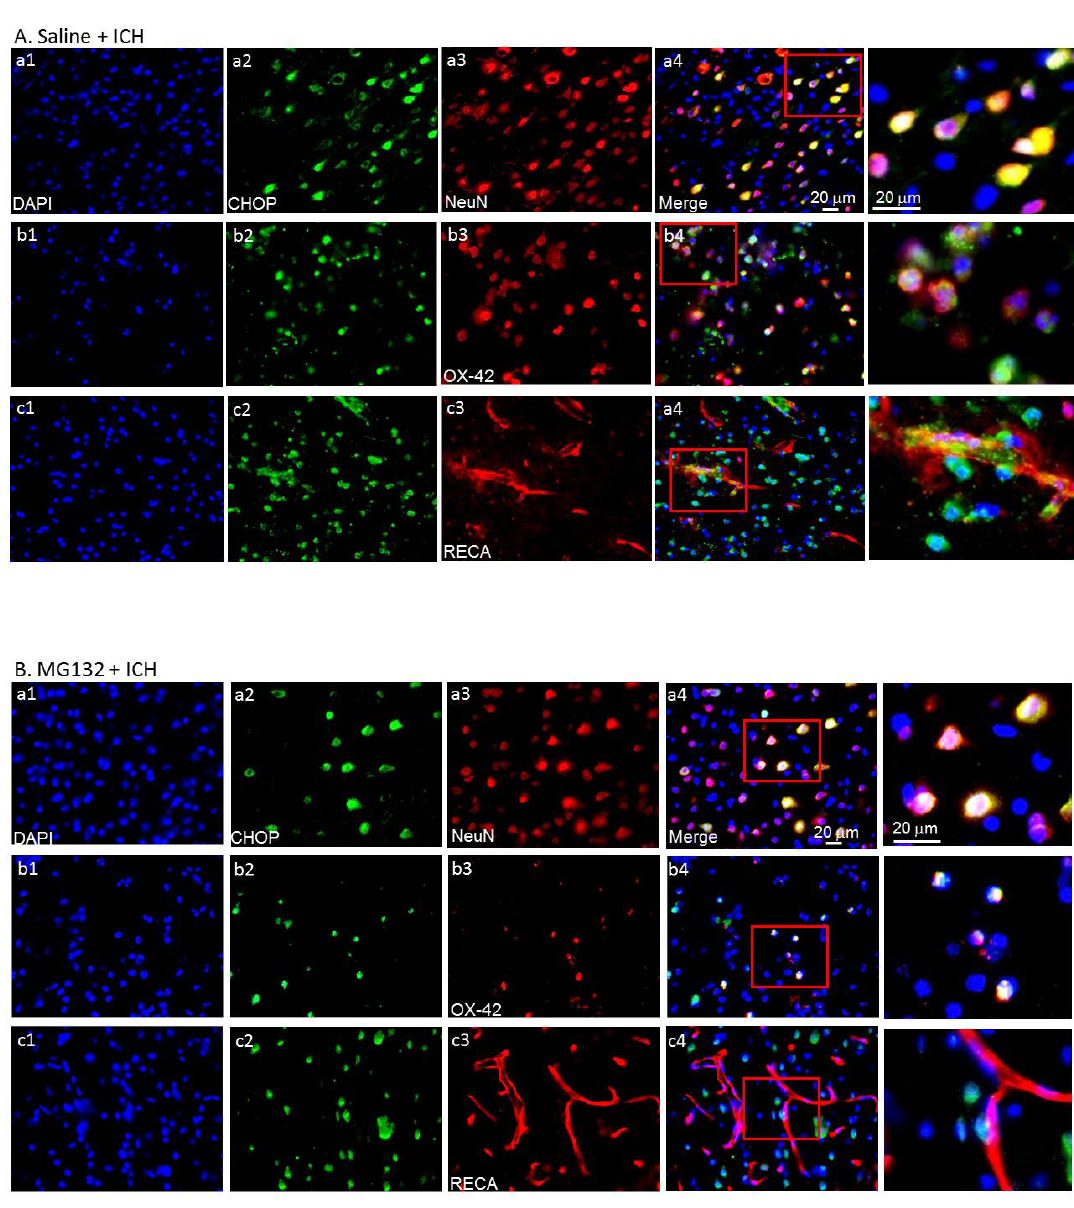
Figure 8. Immunohistochemical staining of CHOP expression at 1 day post-ICH. Yellowish color in the merges (a4, b4, and c4) indicates the co-localization of CHOP expression in neurons (NeuN, a1–a5), microglias (OX-42, b1–b5), and endothelial cells (RECA, c1–c5) in Saline + ICH ( A ) and MG132 + ICH ( B ), respectively.